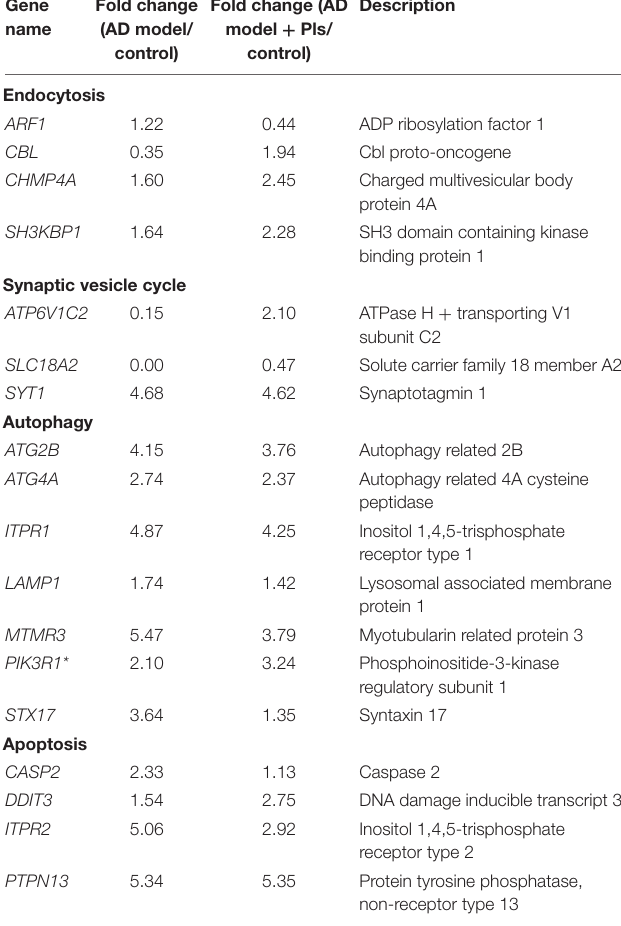
TABLE 4 | List of significant ( p < 0.05) endocytosis, synaptic vesicle cycle, autophagy, and apoptosis-associated DEGs and respective fold changes identified among different groups.